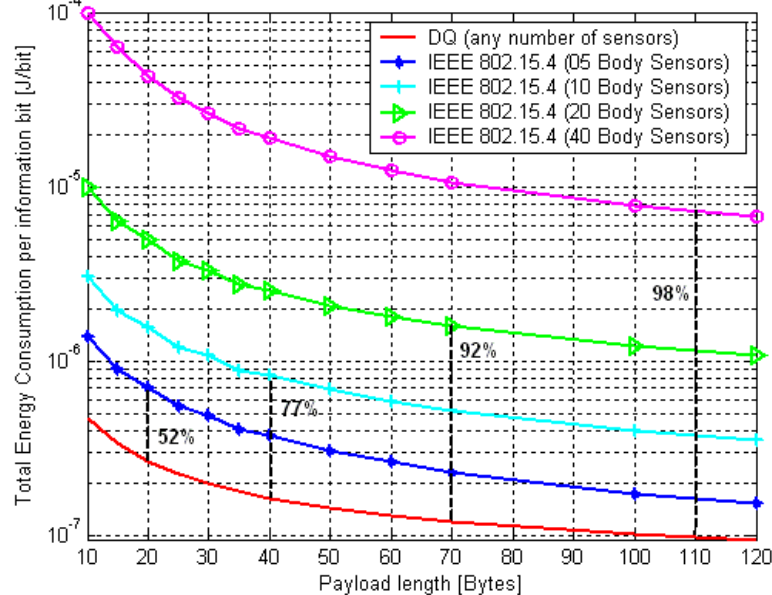
Figure 8. Achievable estimated energy consumption improvement per information bit of DQ MAC vs . IEEE 802.15.4